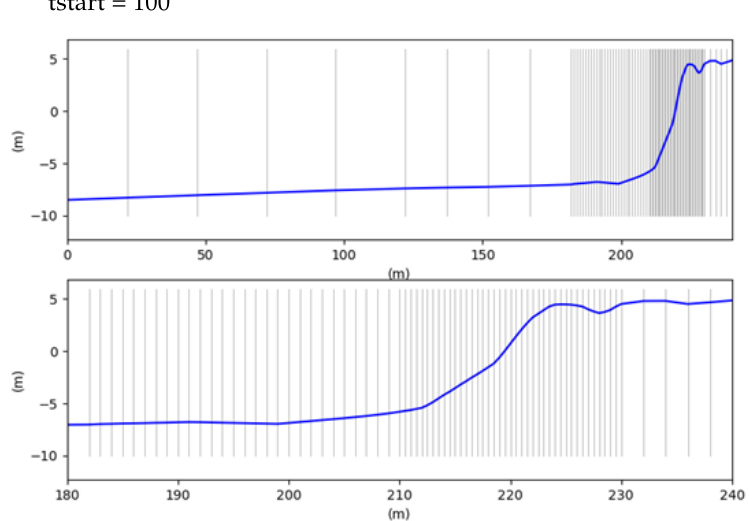
Figure A7. The variable grid spacing along